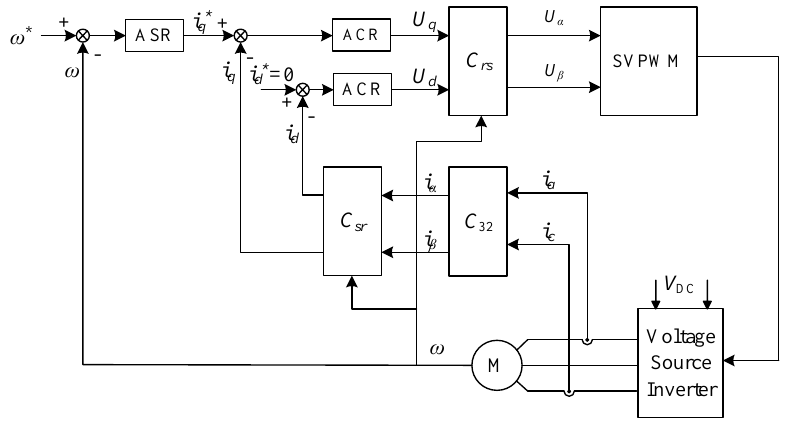
Figure 1. Field-oriented control (FOC) of PMSM.